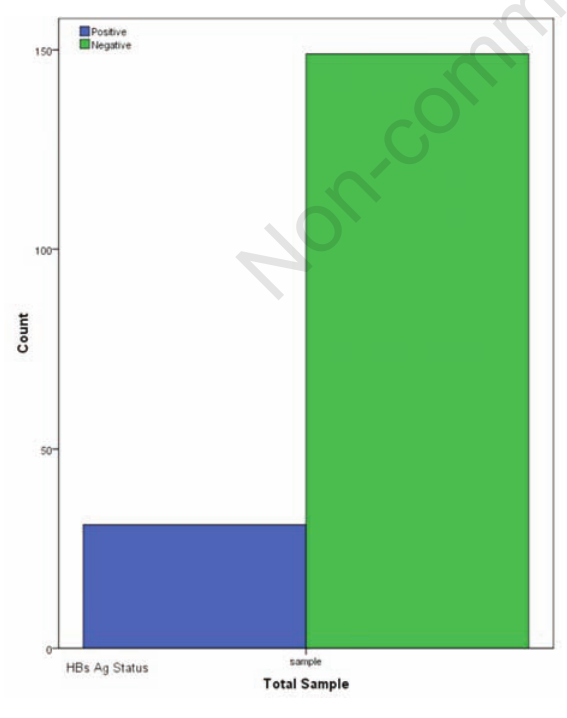
Figure 1. Overall distribution of hepatitis B surface antigen among pregnant women.